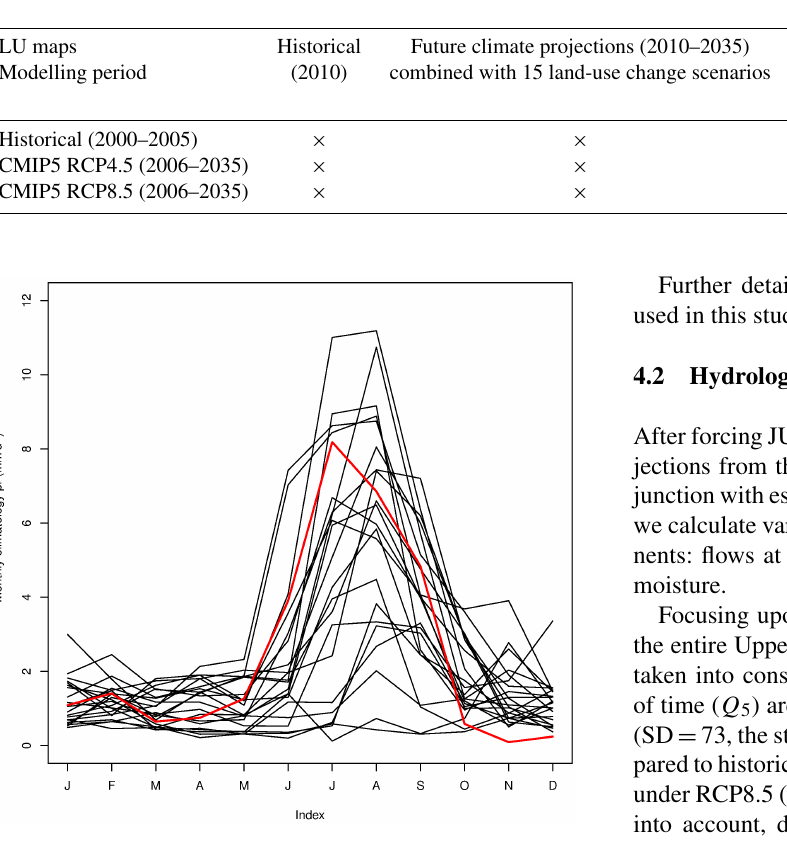
Figure 4. Monthly historical precipitation climatologies of the 21 CMIP5 models used in this study (black) and how they compare to the TRMMv7 satellite product (red), over the period 2000–2005 (the CMIP5 historical experiment ends in 2005). The data corre- spond to areal averages, covering the extent of the Upper Ganges